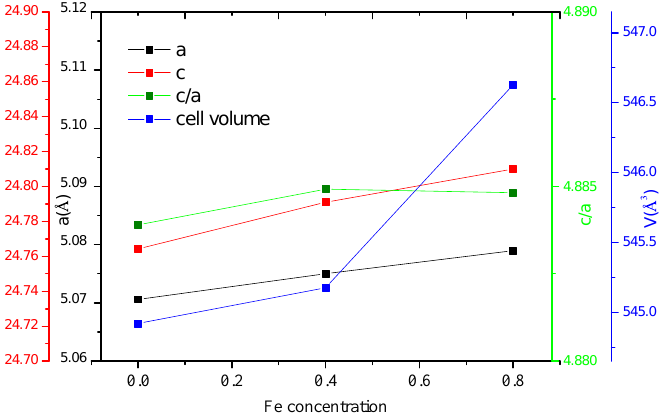
Figure 2. Cell parameter a (Å) (black y -axis), c ( Å ) (red y -axis), c / a (green y -axis), and V (Å 3 ) (blue y -axis) of SmNi 3 − x Fe x plotted against iron